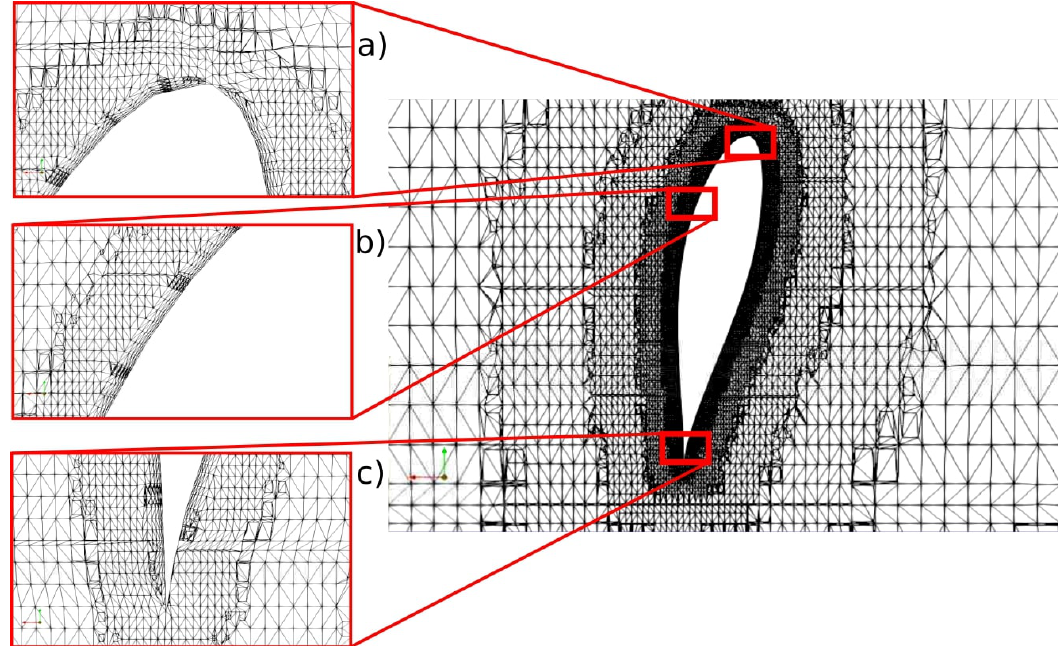
Figure 10. Blade section for a level 9 refinement—the finest mesh (#2.4) with a close-up on leading edge ( a ), trailing edge ( c ) and upper surface ( b ). Distorted elements are due to the visualization